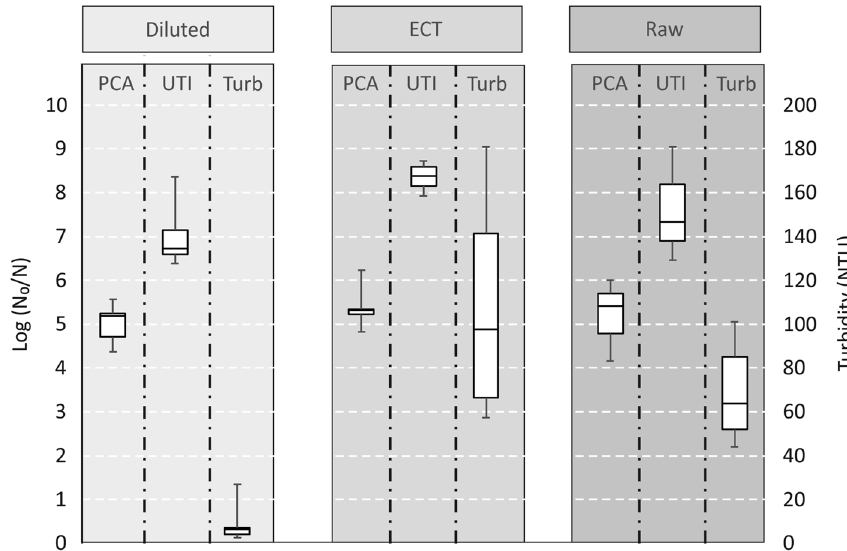
Fig. 3 Log disinfection levels confirmed for wastewaters with different